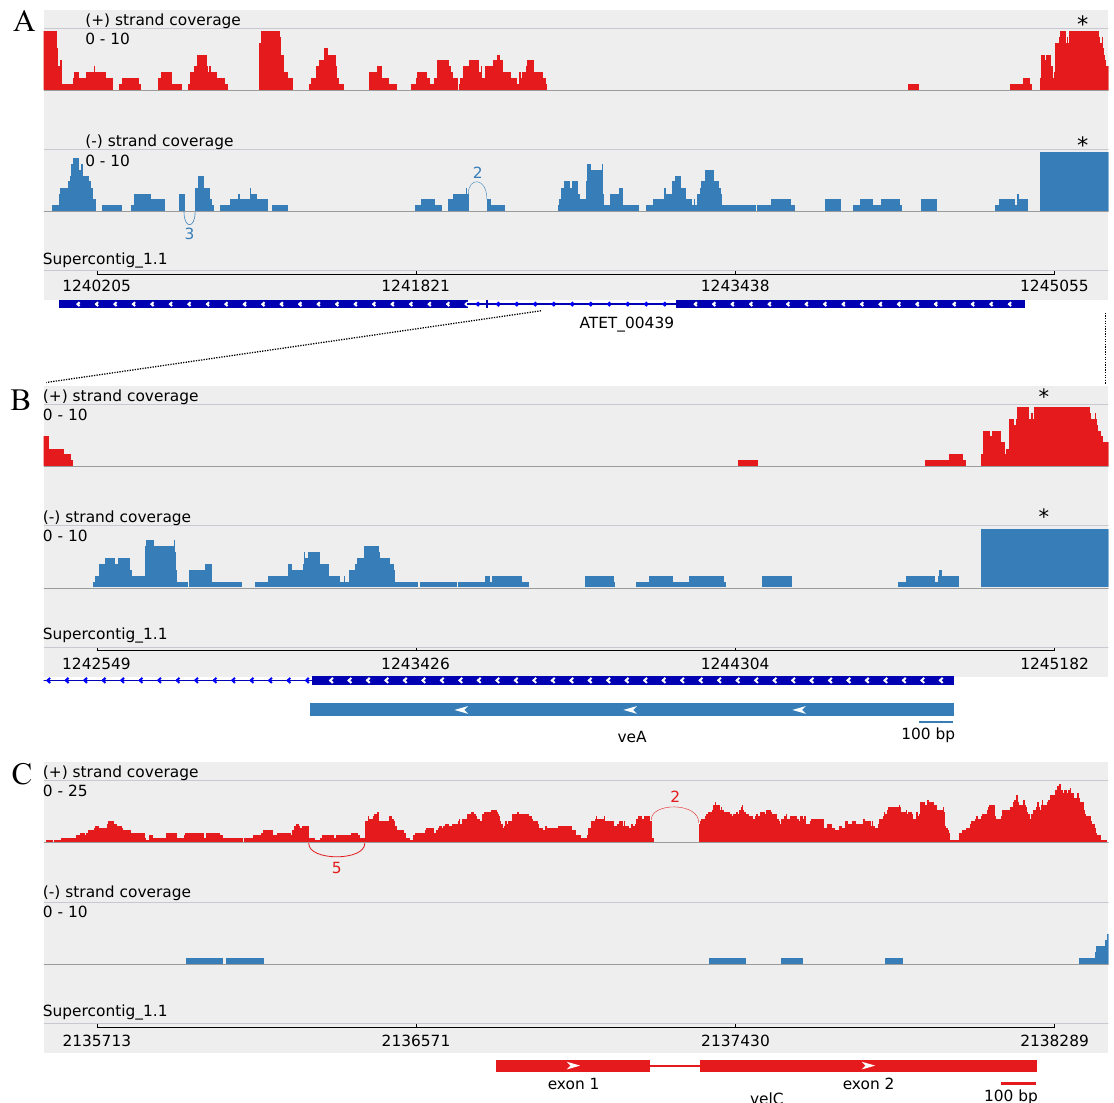
Figure 2. The transcript structures of A. terreus MUCL 38669 veA and velC orthologs. Sashimi plots of ( A ) the whole length of ATEG_00439 as annotated, ( B ) the predicted veA ortholog on 5 (cid:48) of ATEG_00439 and ( C ) the revealed velC ortholog (between ATEG_00762 and ATEG_00763) describing the strand-specific alignment coverage of the read sequences of A. terreus MUCL 38669 over the corresponding genomic regions of supercontig_1.1 of NIH2624. The curved splice junctions represent the number of spliced reads indicating an intron at that specific location. The boxes represent the exons; the arrow heads indicate the genomic strand of the transcript; and the lines represent introns. The veA ORF prediction was obtained using the GENSCAN Web Server [71]. * These apparent coverage blocks consist of minor parts of the transcripts that align over the upstream region of ATEG_00446, indicating this genomic sequence region to be actually part of the upstream region of ATEG_00446 due to the similar transcription level and the corresponding profiles of blunt ends of the blocks (data not